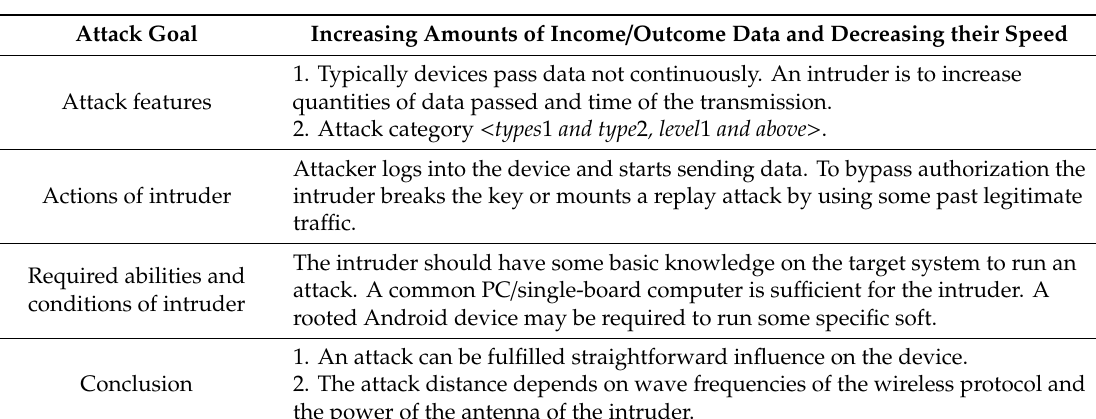
Table 2. Attacks of wireless tra ffi c